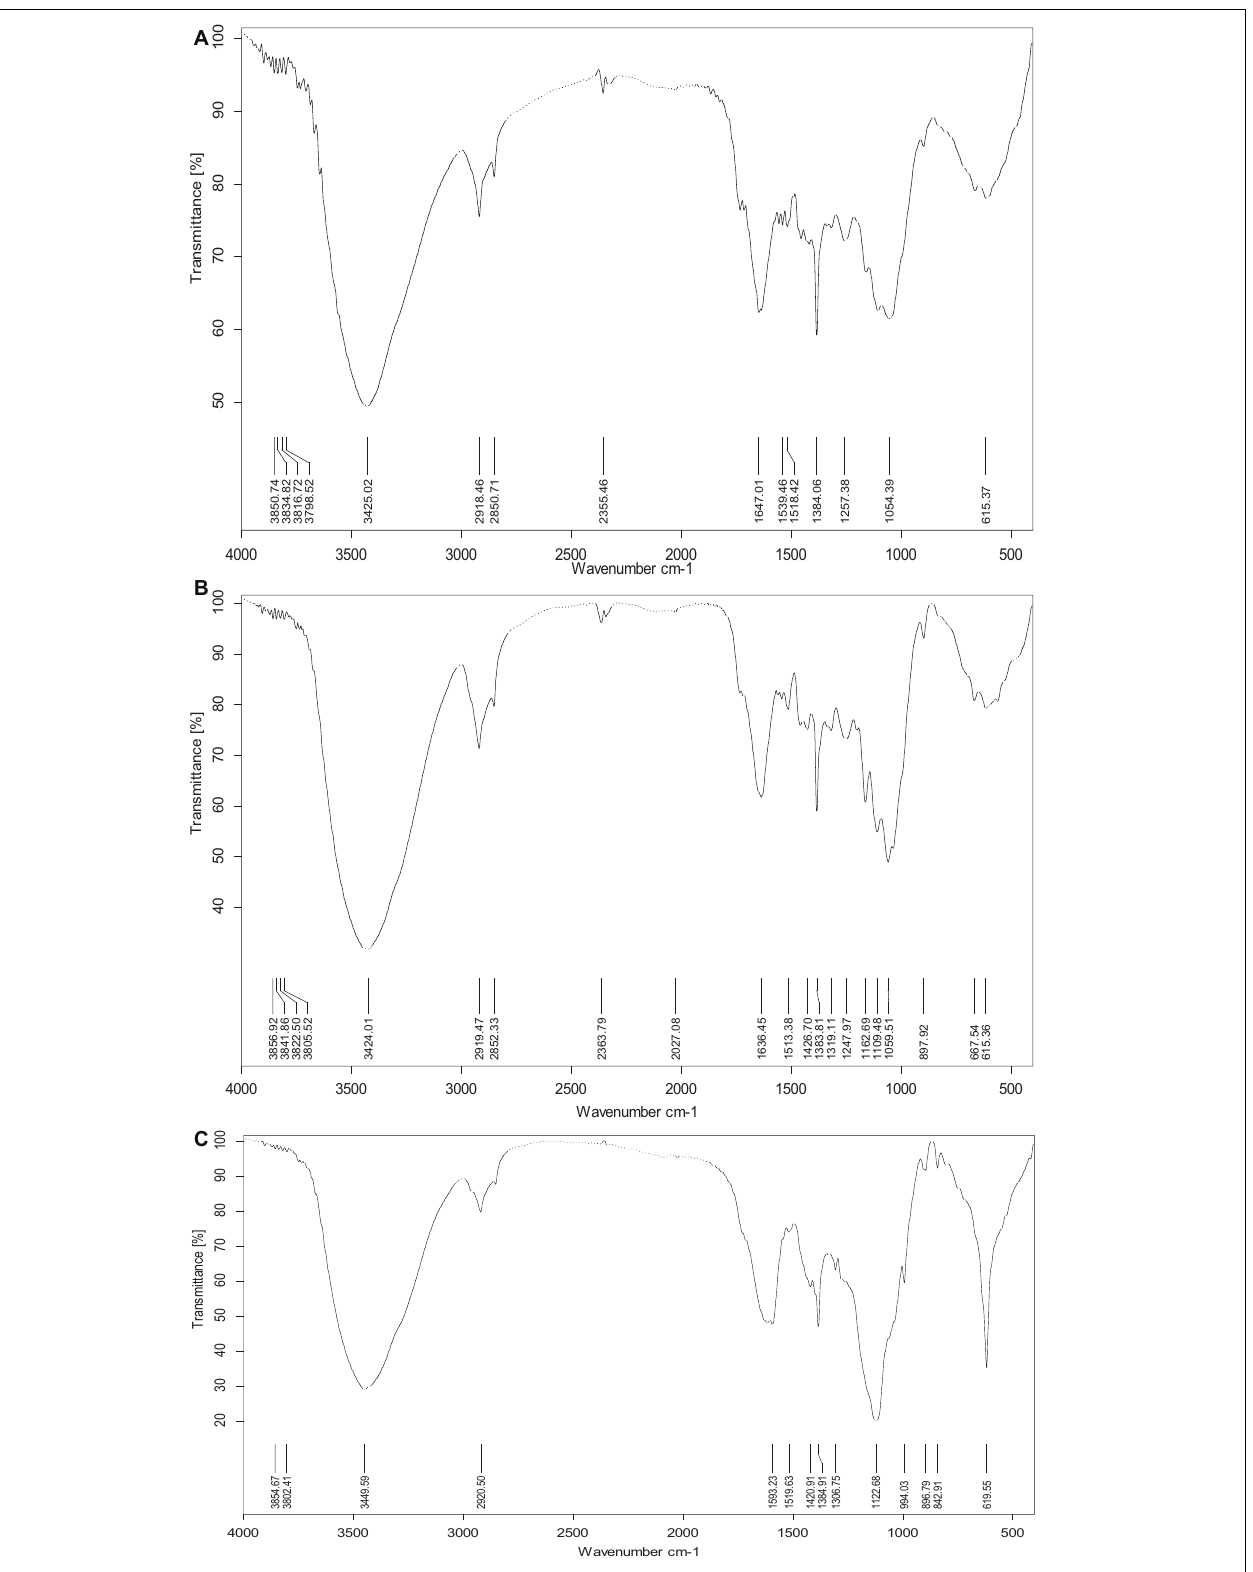
Frontiers in Microbiology |